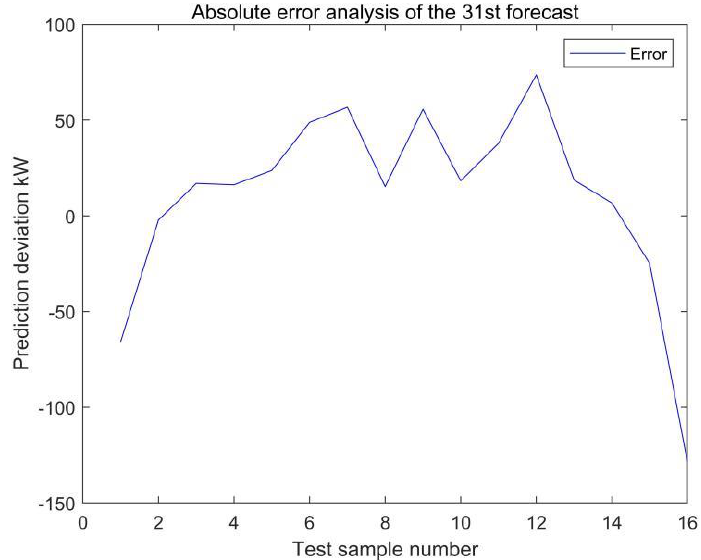
As shown in Figure 25, among the 16 samples, there are 11 samples with absolute errors below 50 kW, 4 samples with 50–100, and only 1 sample with more than 100, and the absolute errors are within the acceptable range. the absolute errors are within the acceptable range.